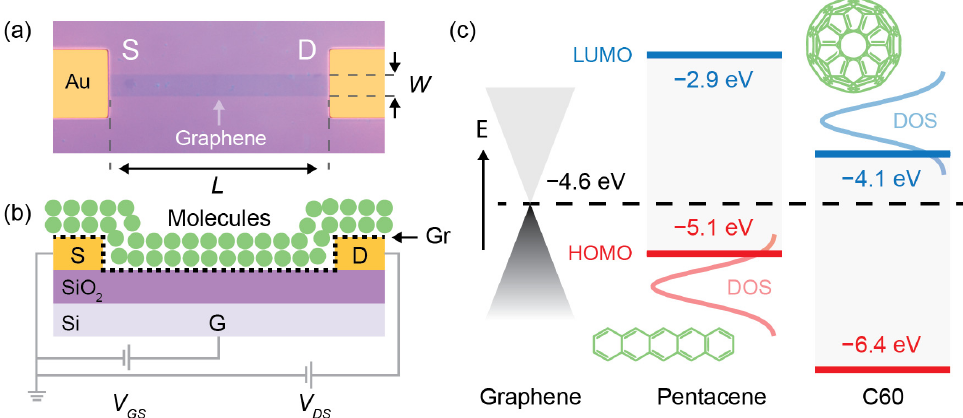
Figure 1. ( a ) Optical microscope image of a representative Graphene Field Effect Transistor (GFET). The channel length L and width W of this device are 50 µm and 5 µm, respectively. The image shows the source (S) and drain (D) gold electrodes on the Si/SiO 2 substrate. ( b ) Electrical schematic of the GFET (not to scale). The cross-section shows the heavily p-doped Si Gate (G), the SiO 2 dielectric (300 nm), the Ti/Au source/drain (5 nm/50 nm) and the Gr channel coated with C60 or Pentacene molecules. The source (S) electrode is connected to ground. In the gate-to-source voltage ( V GS ) sweep, the drain-to-source bias ( V DS ) is kept constant while the current ( I DS ) is measured. ( c ) Energetic representation of the Highest Occupied Molecular Orbital (HOMO) and Lowest Unoccupied Molecular Orbital (LUMO) nominal levels of the C60 and Pentacene molecules with respect to the Fermi energy level of pristine graphene (black dashed line). The Fermi energy of graphene lies within 0.5 eV from the HOMO energy level of Pentacene and within 0.5 eV from LUMO energy level of C60.